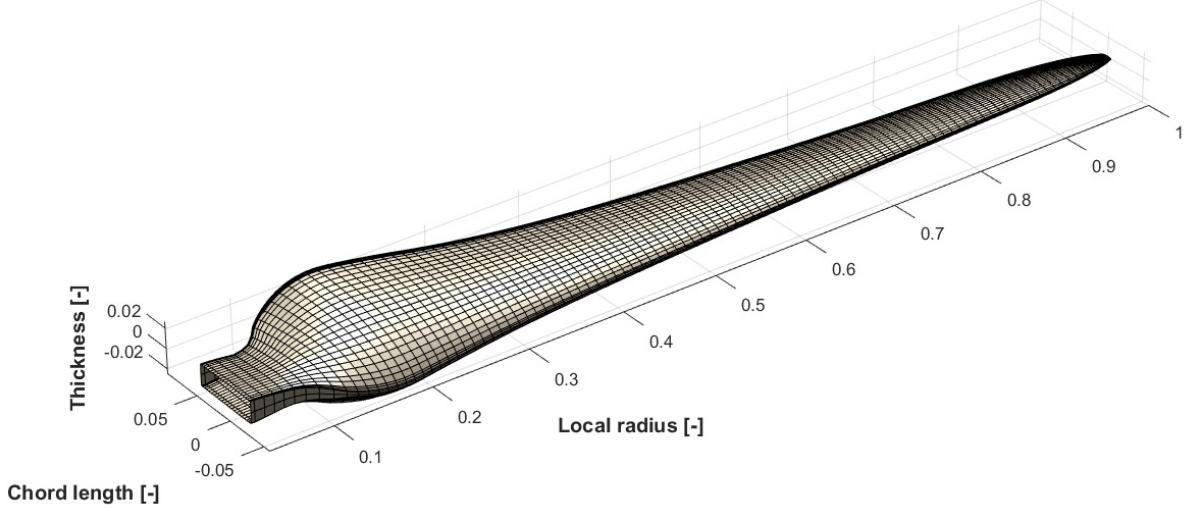
Figure 8. Three-dimensional blade geometry of the designed blade normalized with the radius.